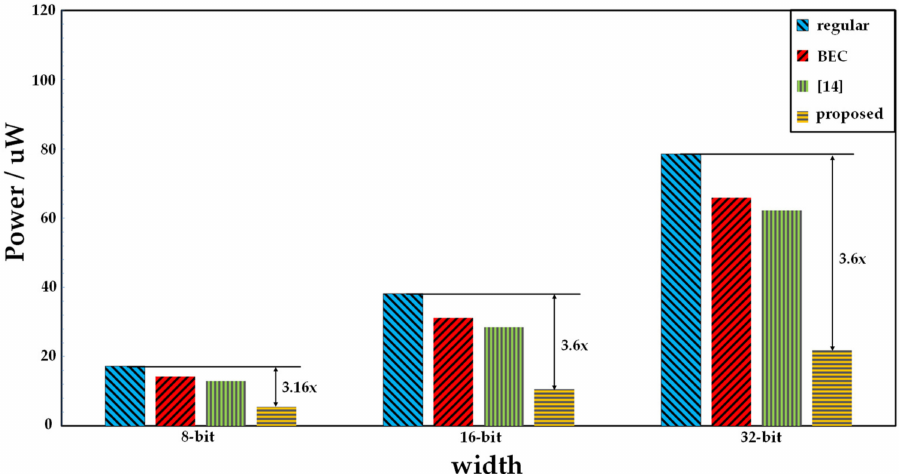
Figure 7. Power comparison among four types of